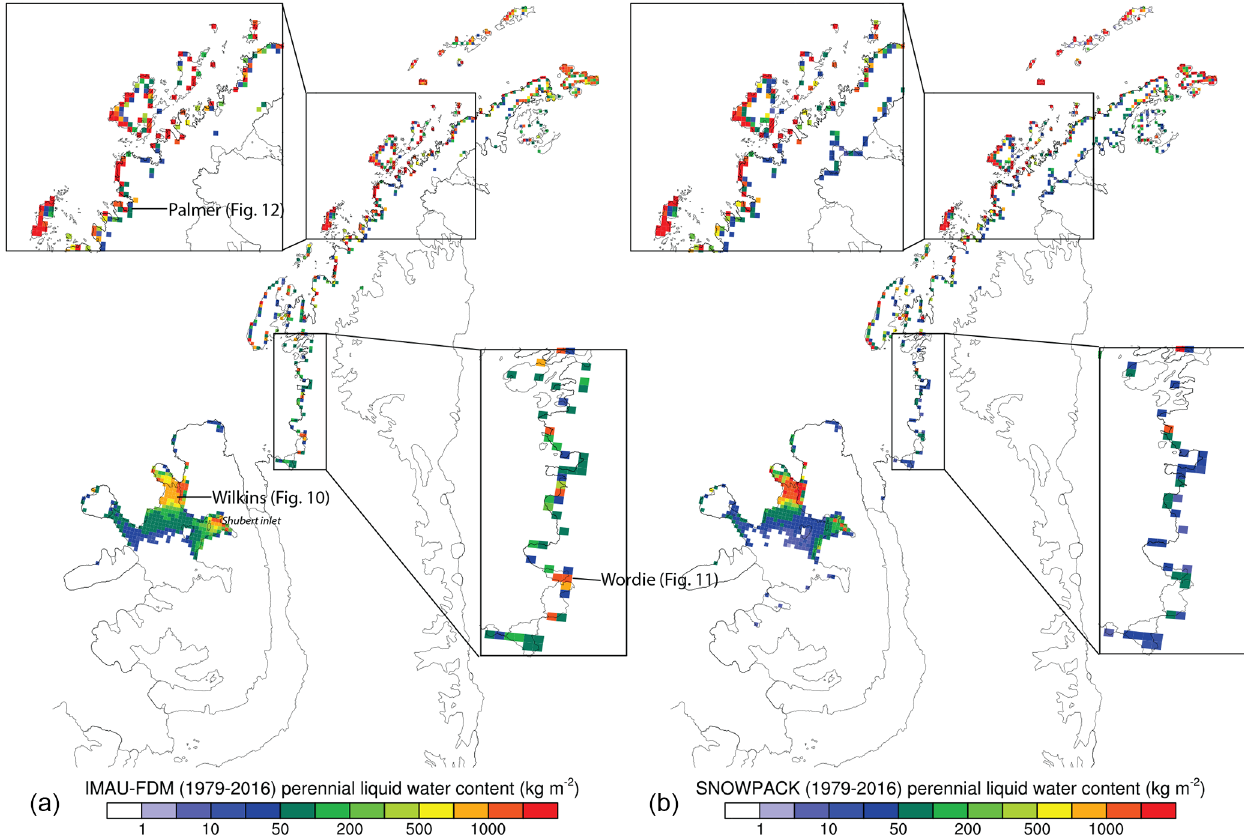
Figure 5. Modelled IMAU-FDM (a) and SNOWPACK (b) annual average (1979–2016) of vertically integrated liquid water content for PFA points; see